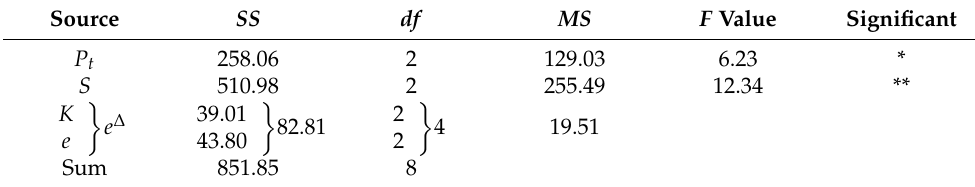
Table 6. Variance analysis performed on the orthogonal test results of CVFU (CV%).